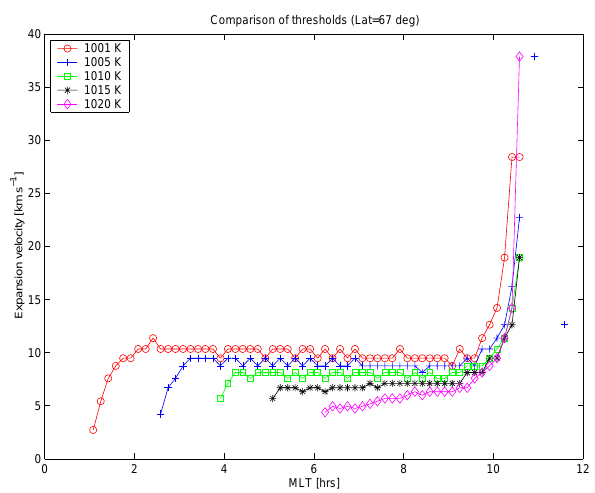
Fig. 5. A comparison of the velocities of the expansion of the model response to reconnection as determined using fixed threshold analy- sis (method 3). The threshold temperatures are absolute values, and are set at intervals above the input neutral temperature, 1000 K.